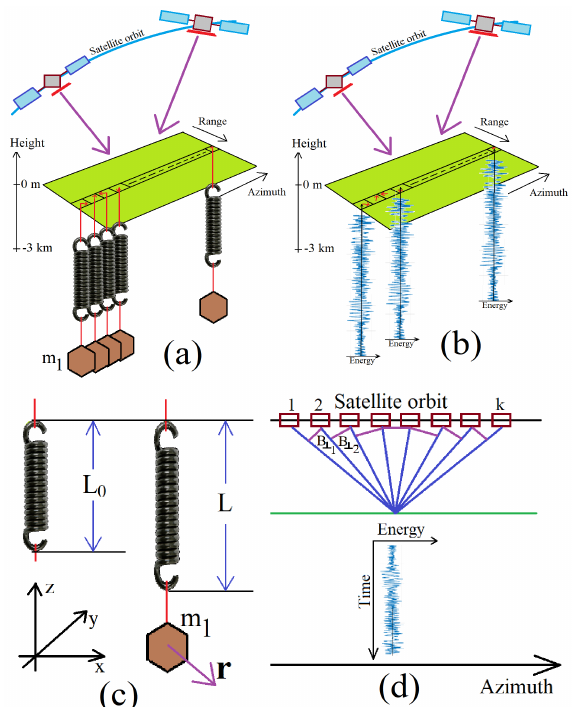
Figure 3. Tomographic acquisition geometry. ( a ) Orbital geometry with the schematic representation of moving masses on the considered pixels. ( b ) Orbital geometry with the measured vibrations present on the considered pixels. ( c ) Details of the spring-mass scheme. ( d ) orthogonal baseline scheme for